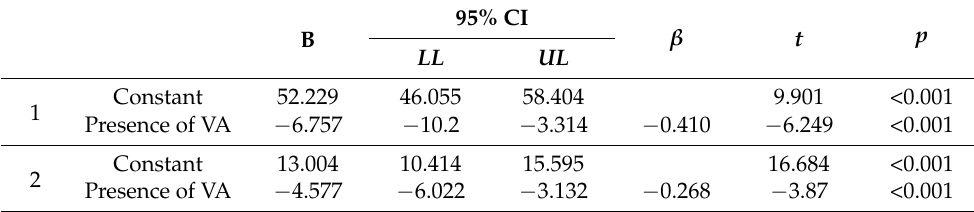
Table 4. Prediction of anxiety (1) and depression (2) scores based on being a VVA.